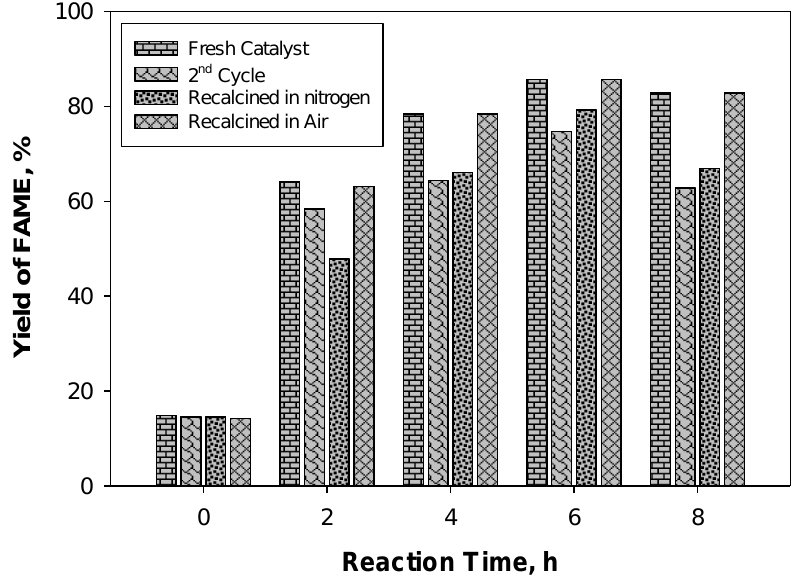
Figure 9. E ff ect of the regeneration of the CaO / PMFA-900-600 catalyst 0–8-h transesterification (at 70 ◦ C, Figure 9. Effect of the regeneration of the CaO/PMFA-900-600 catalyst 0–8-h transesterification (at 70 methanol to oil molar ratio of 6:11 and catalyst loading t of 6 °C, methanol to oil molar ratio of 6:11 and catalyst loading t of 6 wt.%).